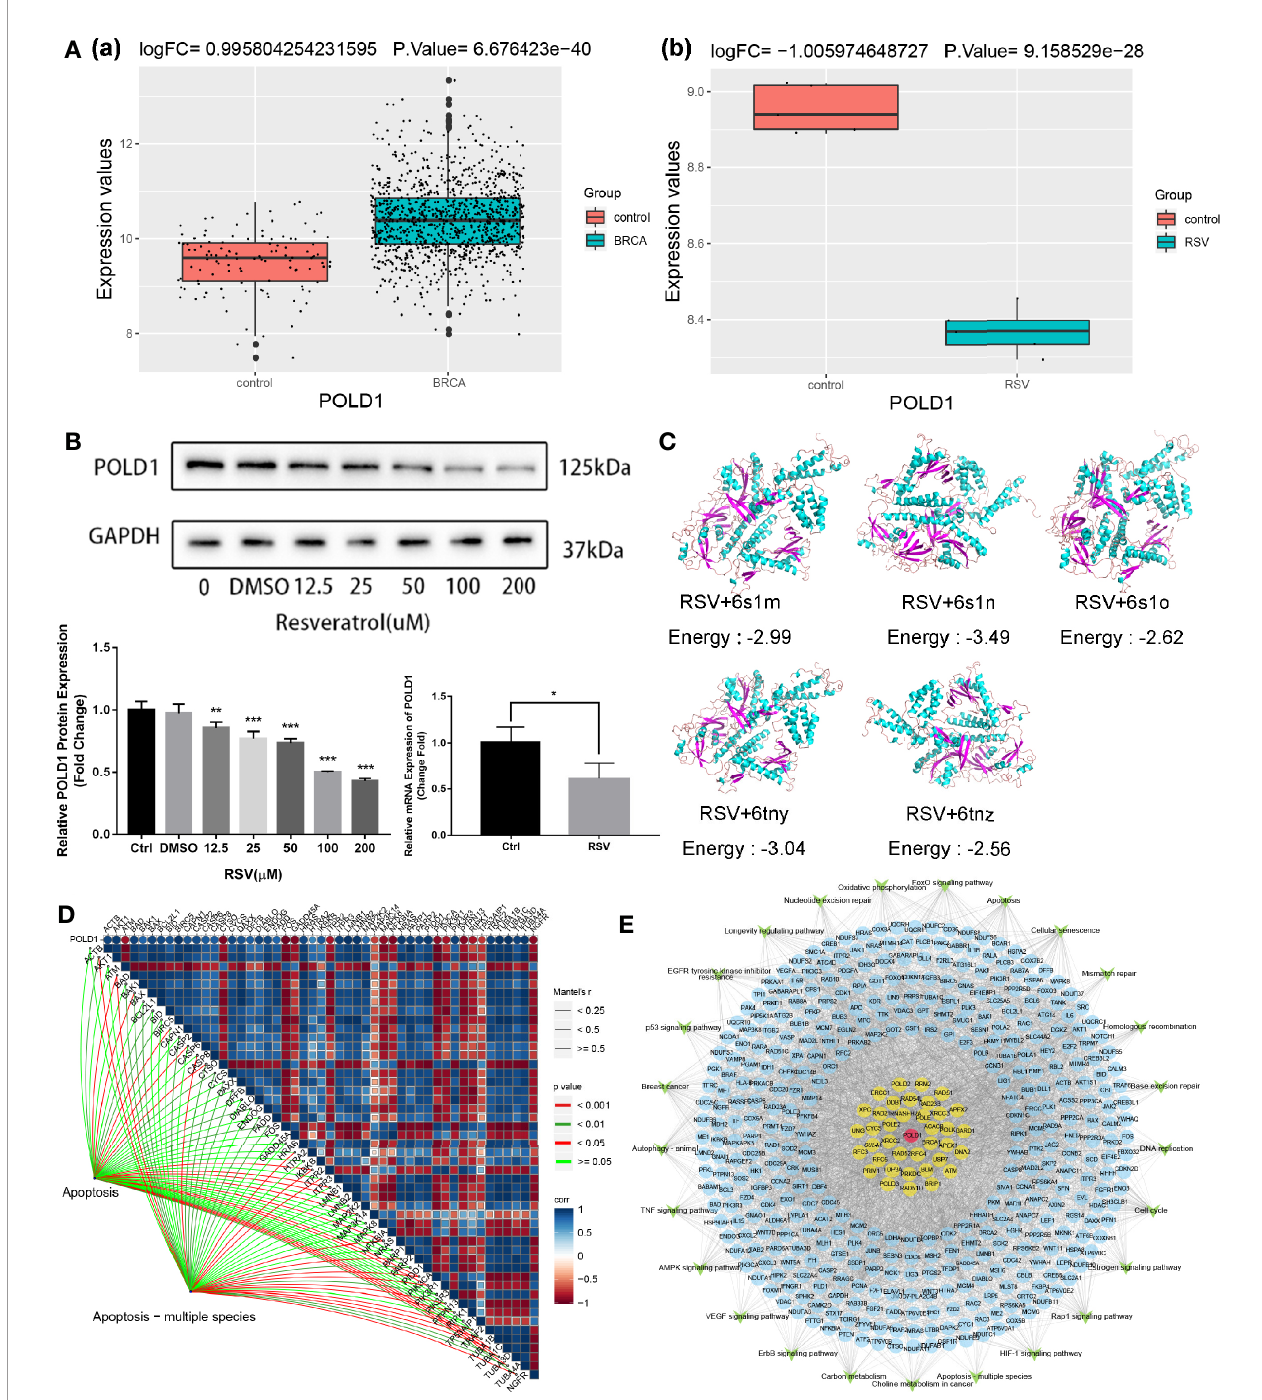
FIGURE 5 | Comprehensive regulatory network for resveratrol in treating MDA-MB-231 cells. (A) (a) POLD1 expression in BRCA samples of TCGA database. (b) POLD1 expression in MDA-MB-231 cells samples after resveratrol treatment. (B) Protein expression of POLD1 after treatment with different concentrations of resveratrol (* P =0.043, ** P =0.004, *** P <0.001). (C) Combined prediction model of resveratrol and POLD1 domain. (D) POLD1-differential apoptotic pathway gene- apoptotic pathway correlation pathway map. (E) Comprehensive regulatory network diagram. Red represents POLD1, yellow represents genes that interact with POLD1, blue represents genes that are affected by other resveratrol treatments for TNBC, and green represents